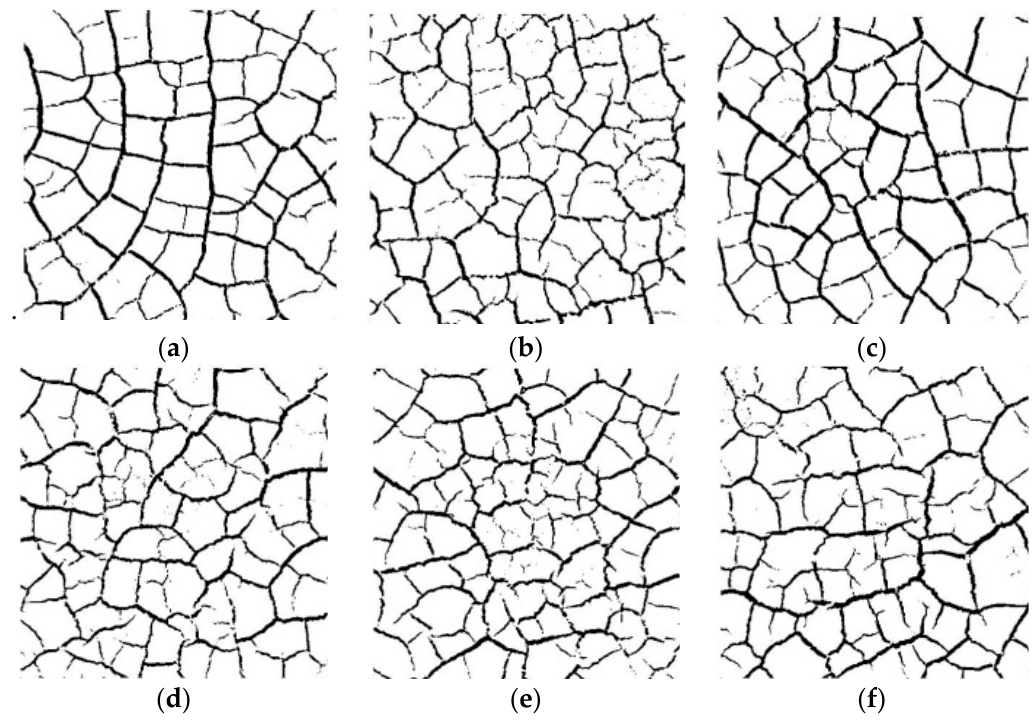
Figure 4. Developmental morphology of two particle size dry shrinkage fissures. ( a ) Group S1 specimens; ( b ) Group S2 specimens; ( c ) Group S3 specimens; ( d ) Group S4 specimens; ( e ) Group S5 specimens; ( f ) Group S6 specimens.